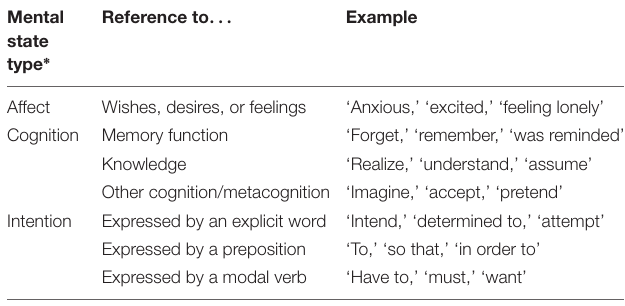
TABLE 2 | Coding frame used to assess frequency of mental state